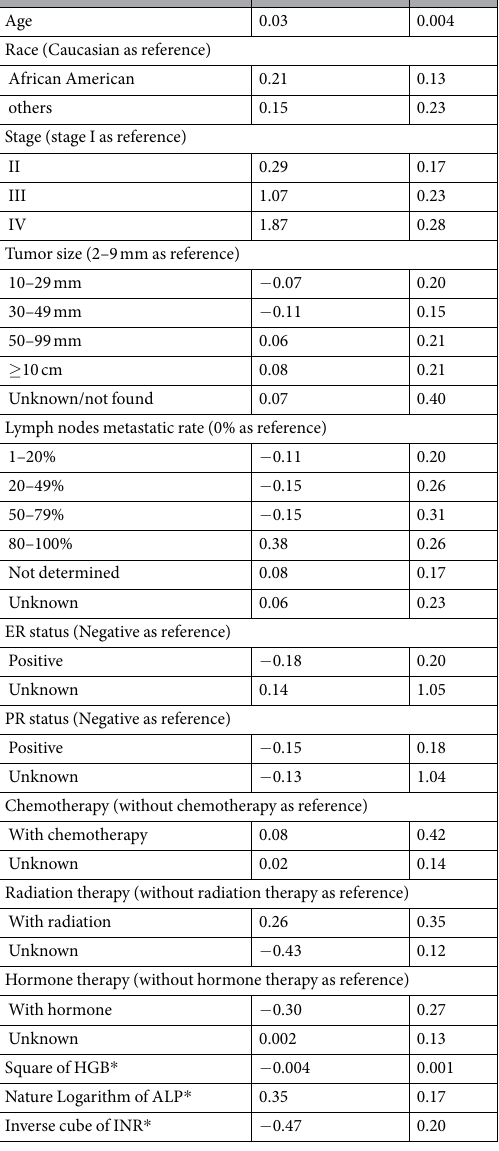
Table 3. Parameter estimates and standard errors in the final model. Abbreviations: ER, estrogen receptor; PR, progesterone receptor; HGB, hemoglobin; ALP, alkaline phosphatase; INR, international normalized ratio; SE, standard error. * In order to calculate the prognostic index for the testing set, the missing data of HGB, ALP, and INR in the testing set were imputed as the mean values from the training set (after normality transformation, 154.57 for HGB, 4.24 for ALP, and 0.93 for INR,